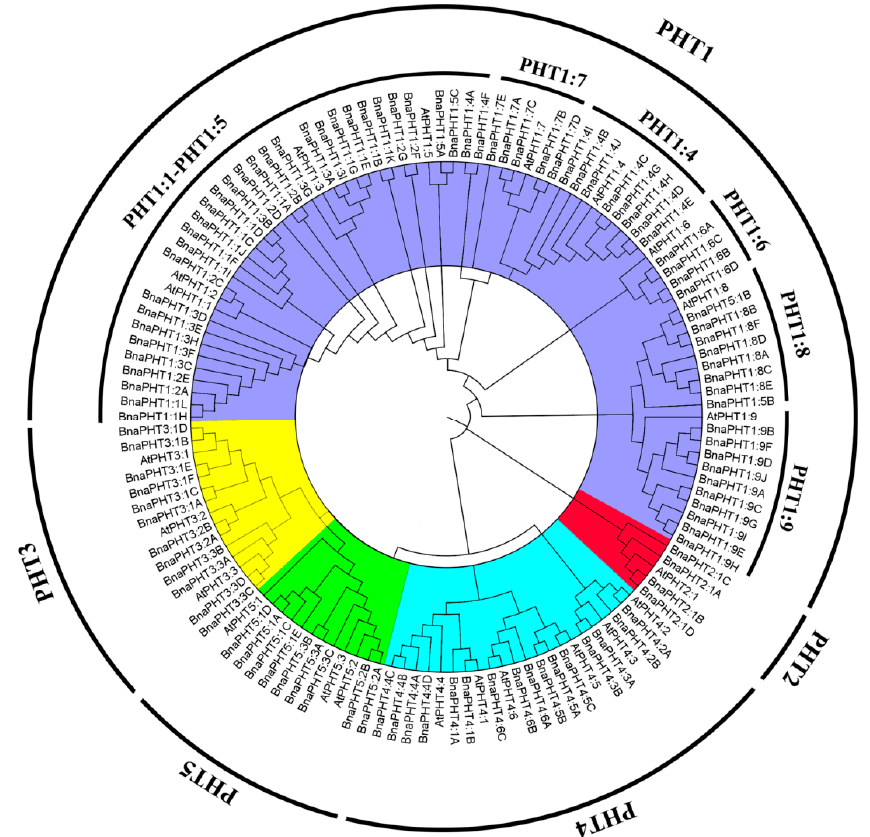
Figure 1. Phylogenetic tree of PHT proteins from A. thaliana and five Brassica species. The phylogenetic tree was constructed using the neighbor-joining method with 1000 bootstrap replicates in MEGA7 (https://www.megasoftware.net/) and visualized using FigTree v1.4.4 (http://tree.bio.ed.ac.uk/software/figtree/). The PHTs were divided into five subfamilies ( PHT1– PHT5 ), which are indicated by different colors. Gene names and accession numbers are shown in Table S1.